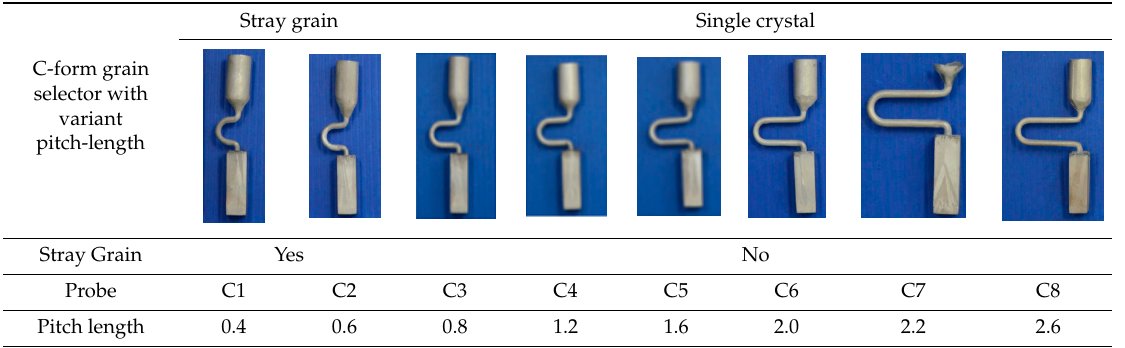
Table 2. Di ff erent pitch length parameters of C-form grain selectors: Group 2.